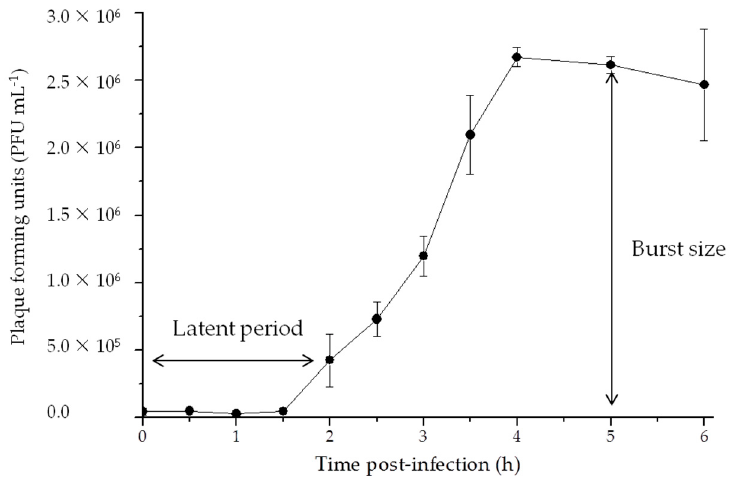
Figure 2. One-step growth curve of the phage R5C.